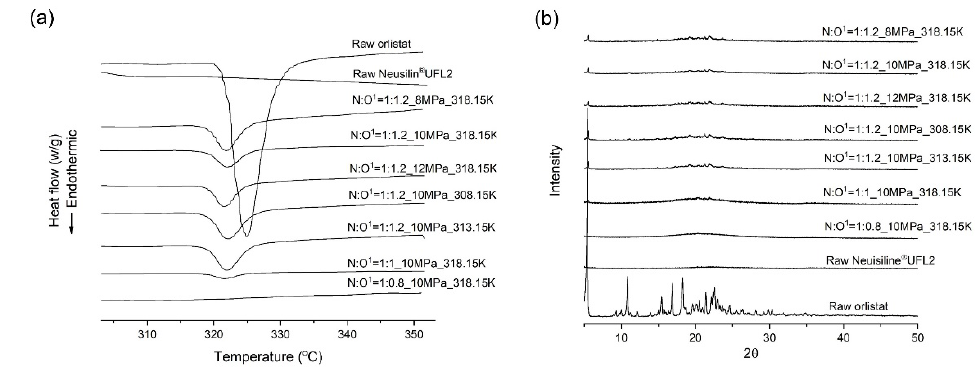
Figure 6. ( a ) DSC thermograms and ( b ) powder X-ray diffraction (PXRD) patterns for raw materials and orlistat-loaded Neusilin ® UFL2 samples prepared by MA-SCF at various pressure and temperature. 1 N:O is the mass ratio of Neusilin ® UFL2:Orlistat.